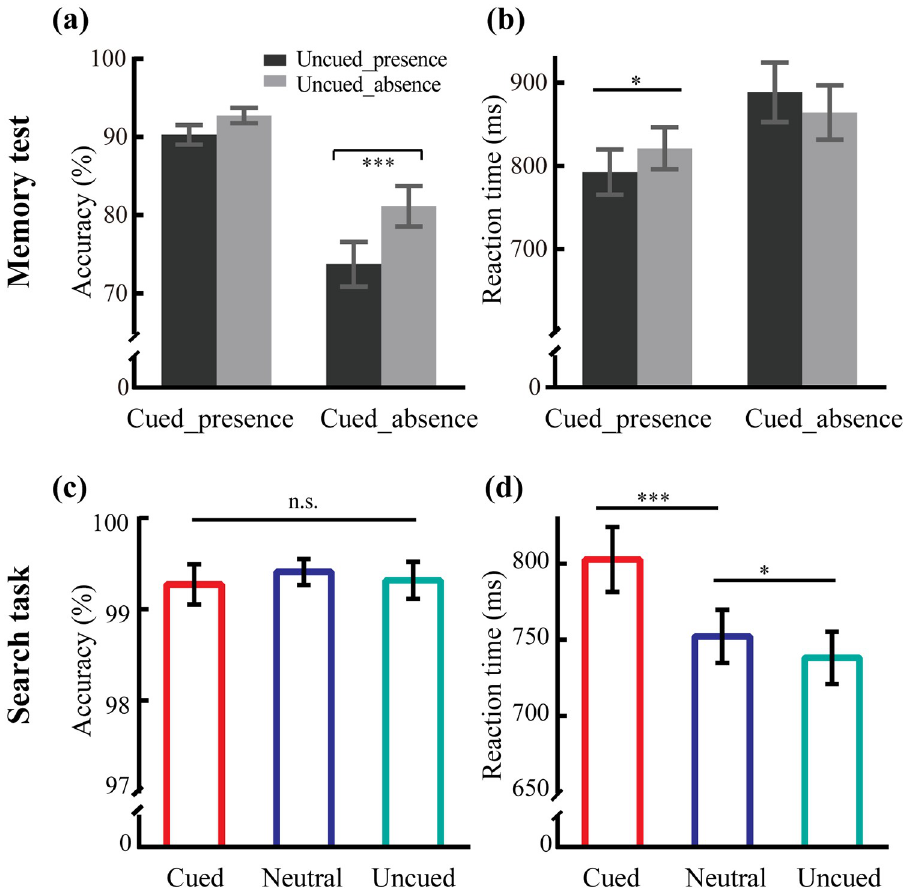
Fig 2. Results of reaction time and accuracy in the search task and memory test, respectively. Error bars denote the standard error of the mean (SEM). n.s. = non-significant, � p < .05, ��� p < .001.